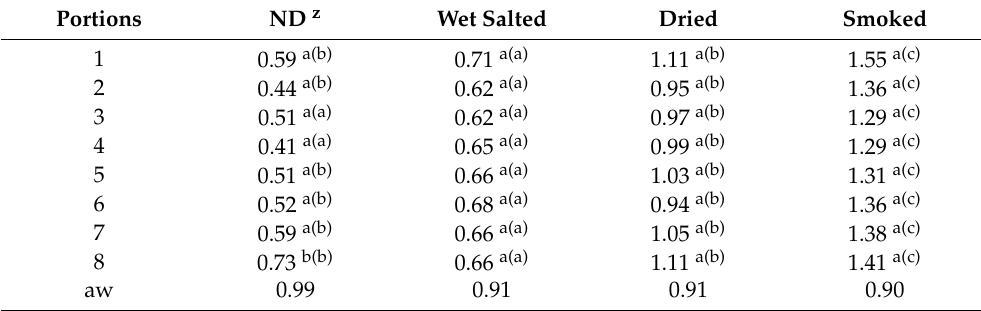
Table 5. NaCl concentration (%) in swordfish fillets after industrial wet salting, drying, and smoking. Portions ND z Wet Salted Dried Smoked 1 0.59 a(b) 0.71 a(a) 1.11